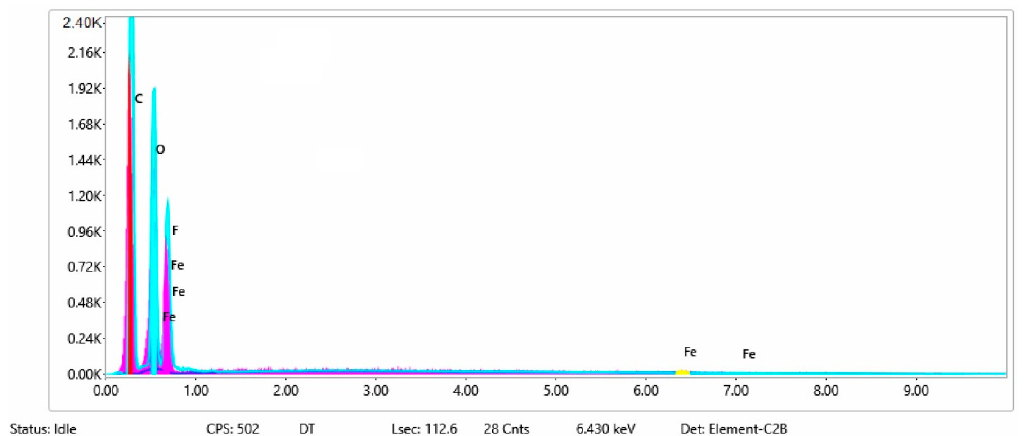
Figure 4. EDS spectra for sample 2 (fabric treated using a preliminary classical cleaning method and conductive paste).